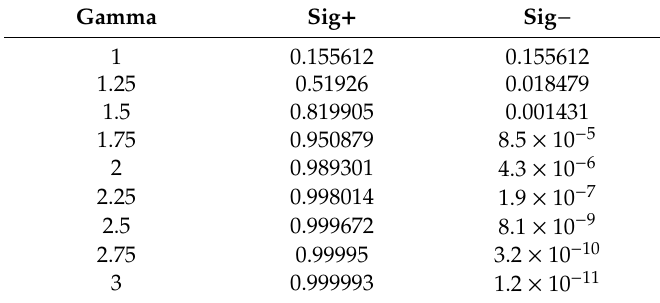
Table 6. Sensitivity analysis